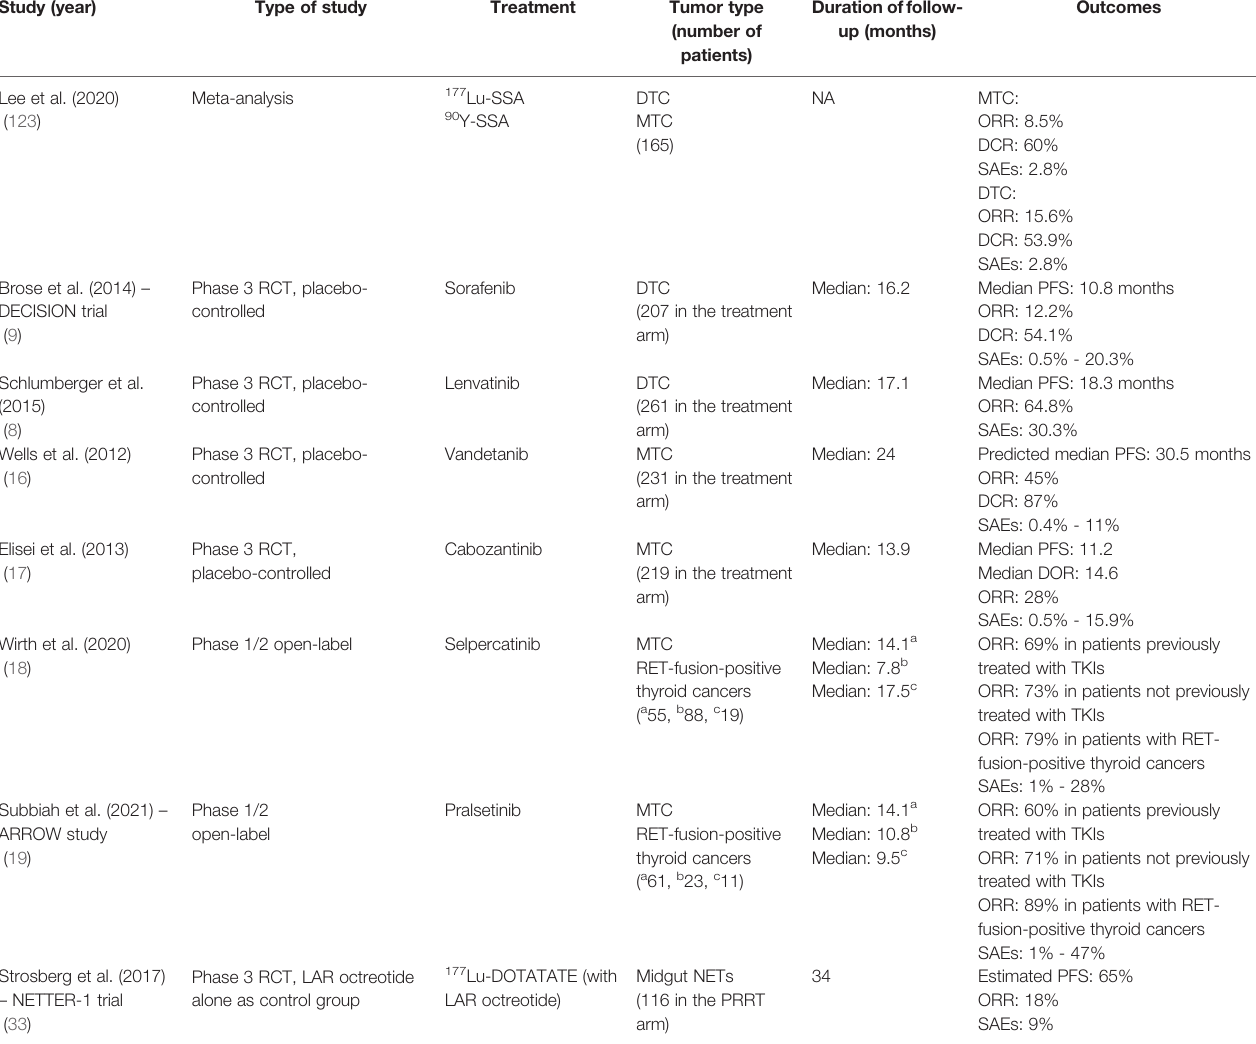
TABLE 2 | A comparison of the outcomes of PRRT in thyroid cancer, other systemic therapies in thyroid cancer, and PRRT in NETs.